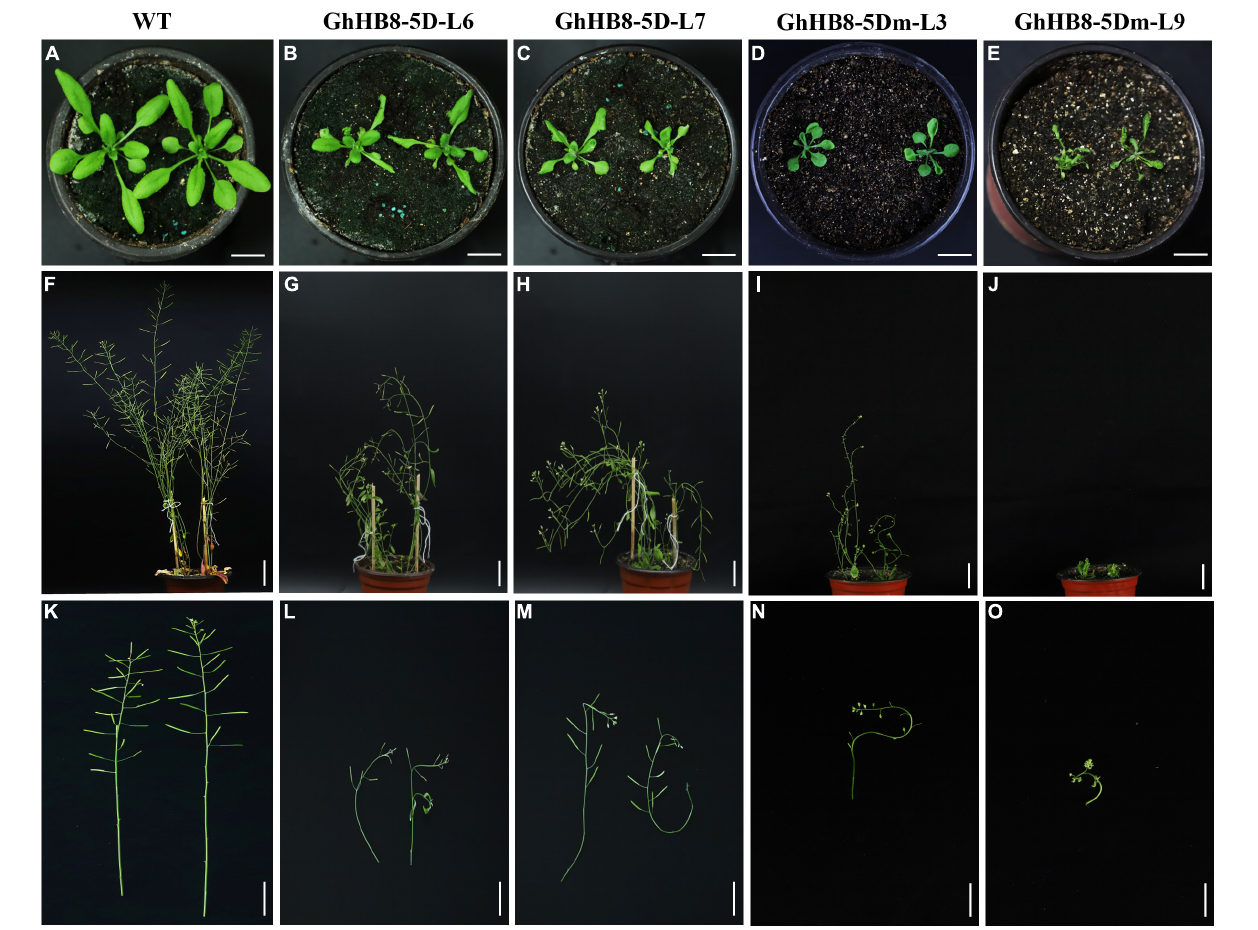
FIGURE 7 | The phenotype of wild type and GhHB8-5D and GhHB8-5Dm transgenic lines. (A–E) Three-week-old seedlings of wild type and transgenic lines. (F–J) Six-week-old plants of wild type and transgenic lines. (K–O) Magnified images of the inflorescence stem from 6-week-old wild type and transgenic lines. WT represent wild type plants. L6 and L7 indicate two independent lines of GhHB8-5D overexpression plants. L3 and L9 denote two independent lines of GhHB8-5Dm overexpression plants in which the miR166 binding site was executed synonymous mutation. Bars = 1 cm.